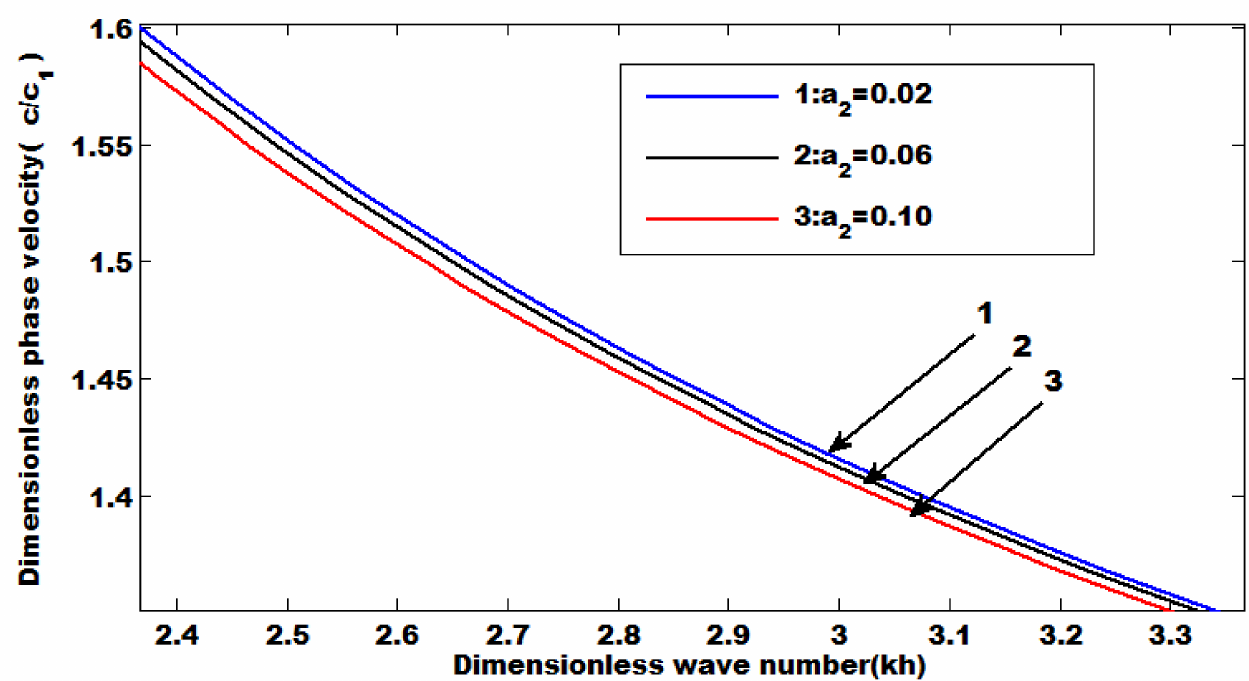
Figure 7. The phase velocity with wave number when a 1 = 0, m = 0.08, h = 0.04, p = 0.01, α = 0.2, β = 0.1.